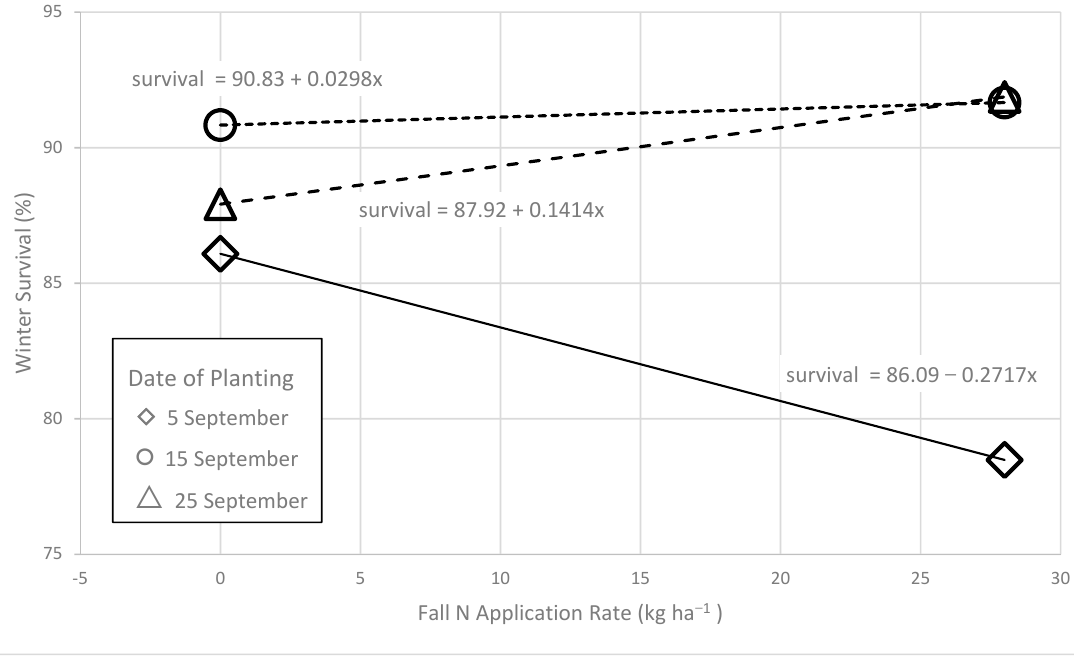
Figure 3. Interactive effect of fall N application (kg ha − 1 ) at planting dates of 5, 15, and 25 of September on winter survival (%).